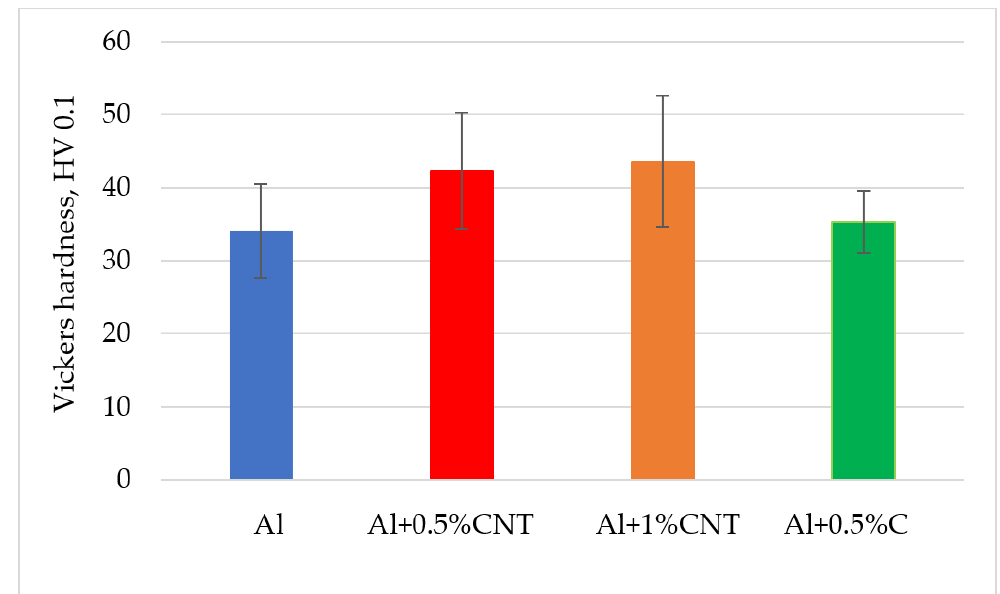
Figure 11. Comparison of average cross-sectional hardness and standard deviation for each of the investigated coatings.